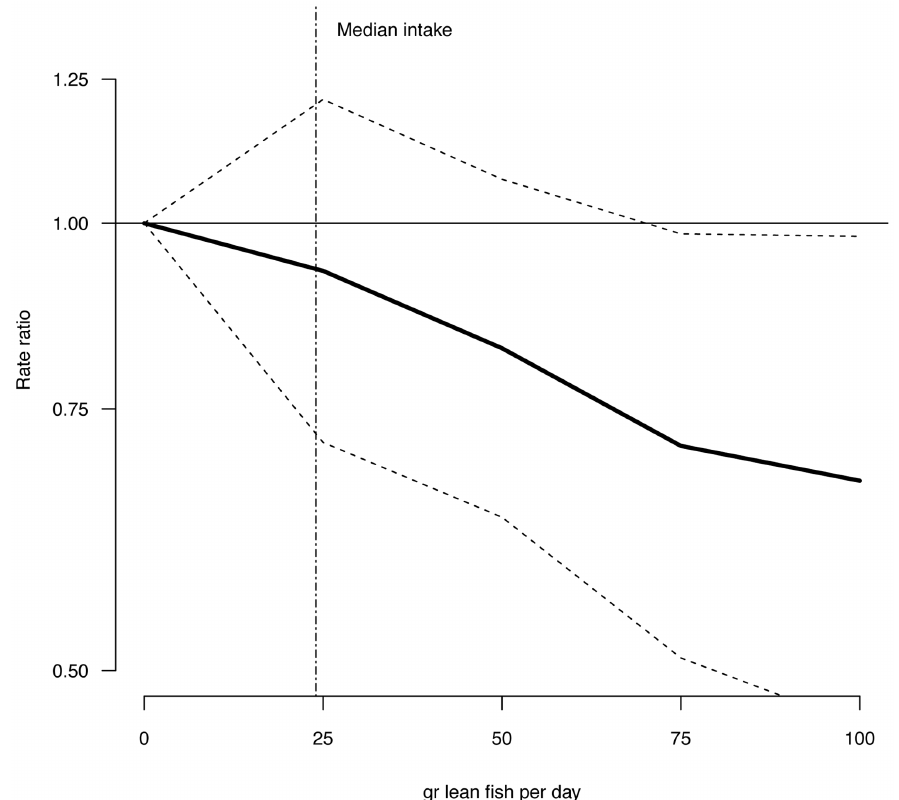
Figure 1. Risk ratios (RR) and 95% CI of T2DM by lean fish consumption. RRs are indicated by the solid line and the 95% CI by the dashed horizontal lines. Numbers are adjusted for BMI, hypertension, smoking status, age and physical activity. Median intake of lean fish in the study group is indicated by the dashed vertical line.